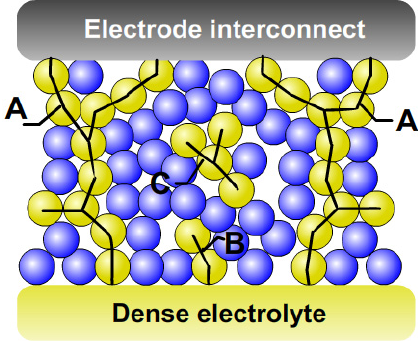
Figure 3. Microstructure of a two-component, randomly packed mixture of LSCF and YSZ